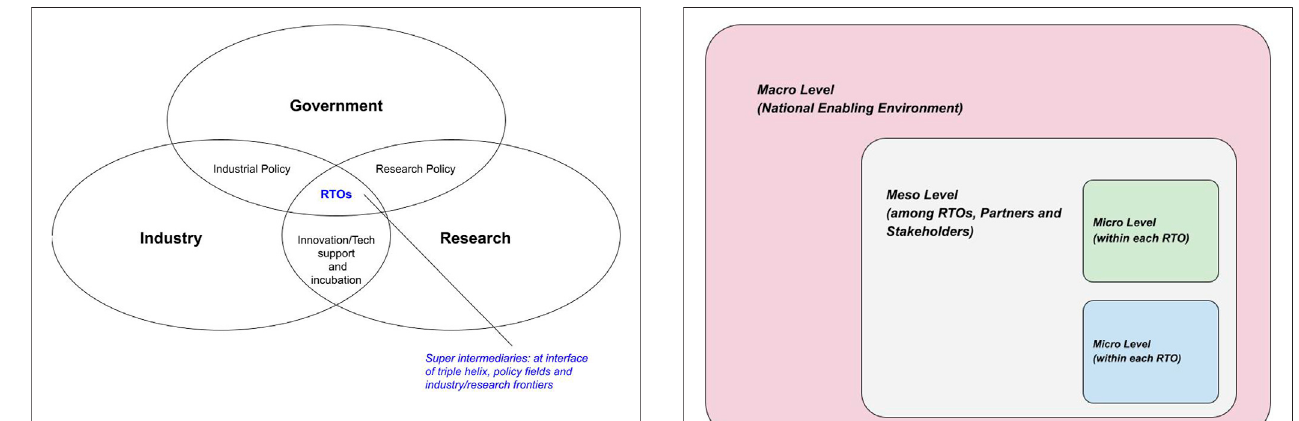
FIGURE 1 | Conceptual framework of RTOs as super intermediaries.